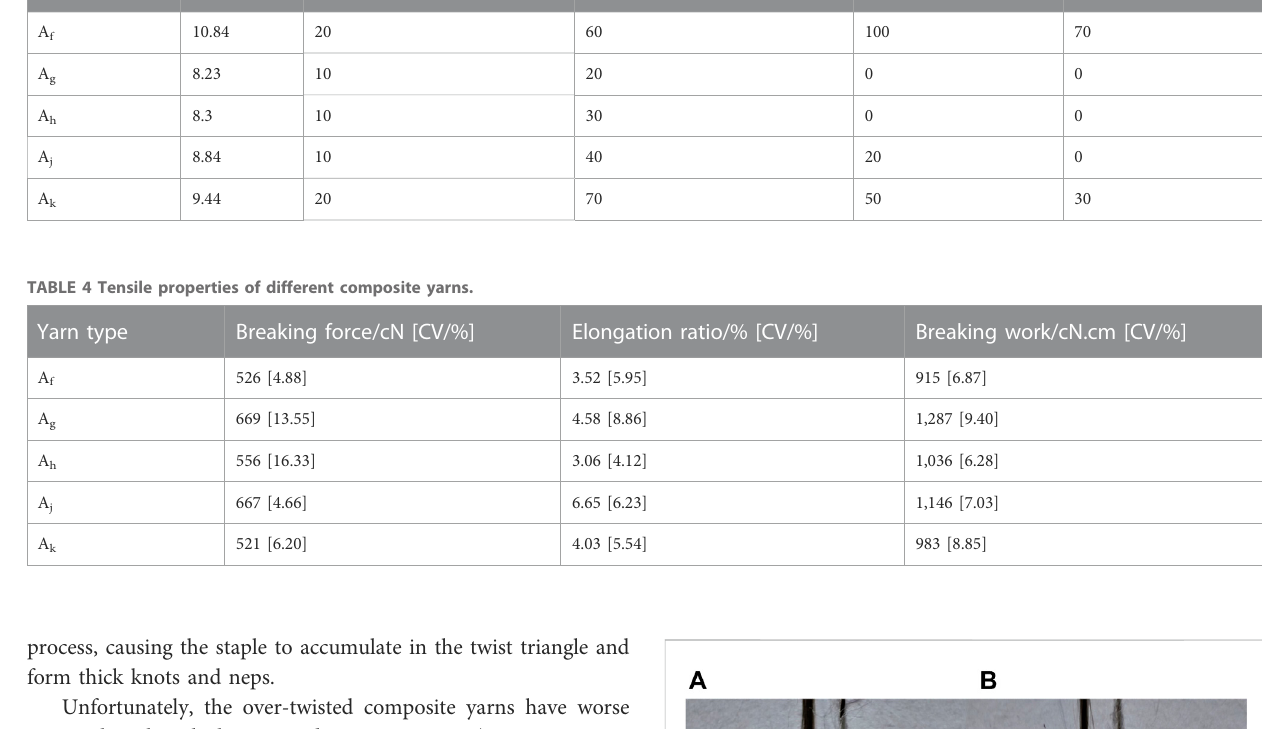
TABLE 3 Irregularity parameters of different composite yarns. Yarn type